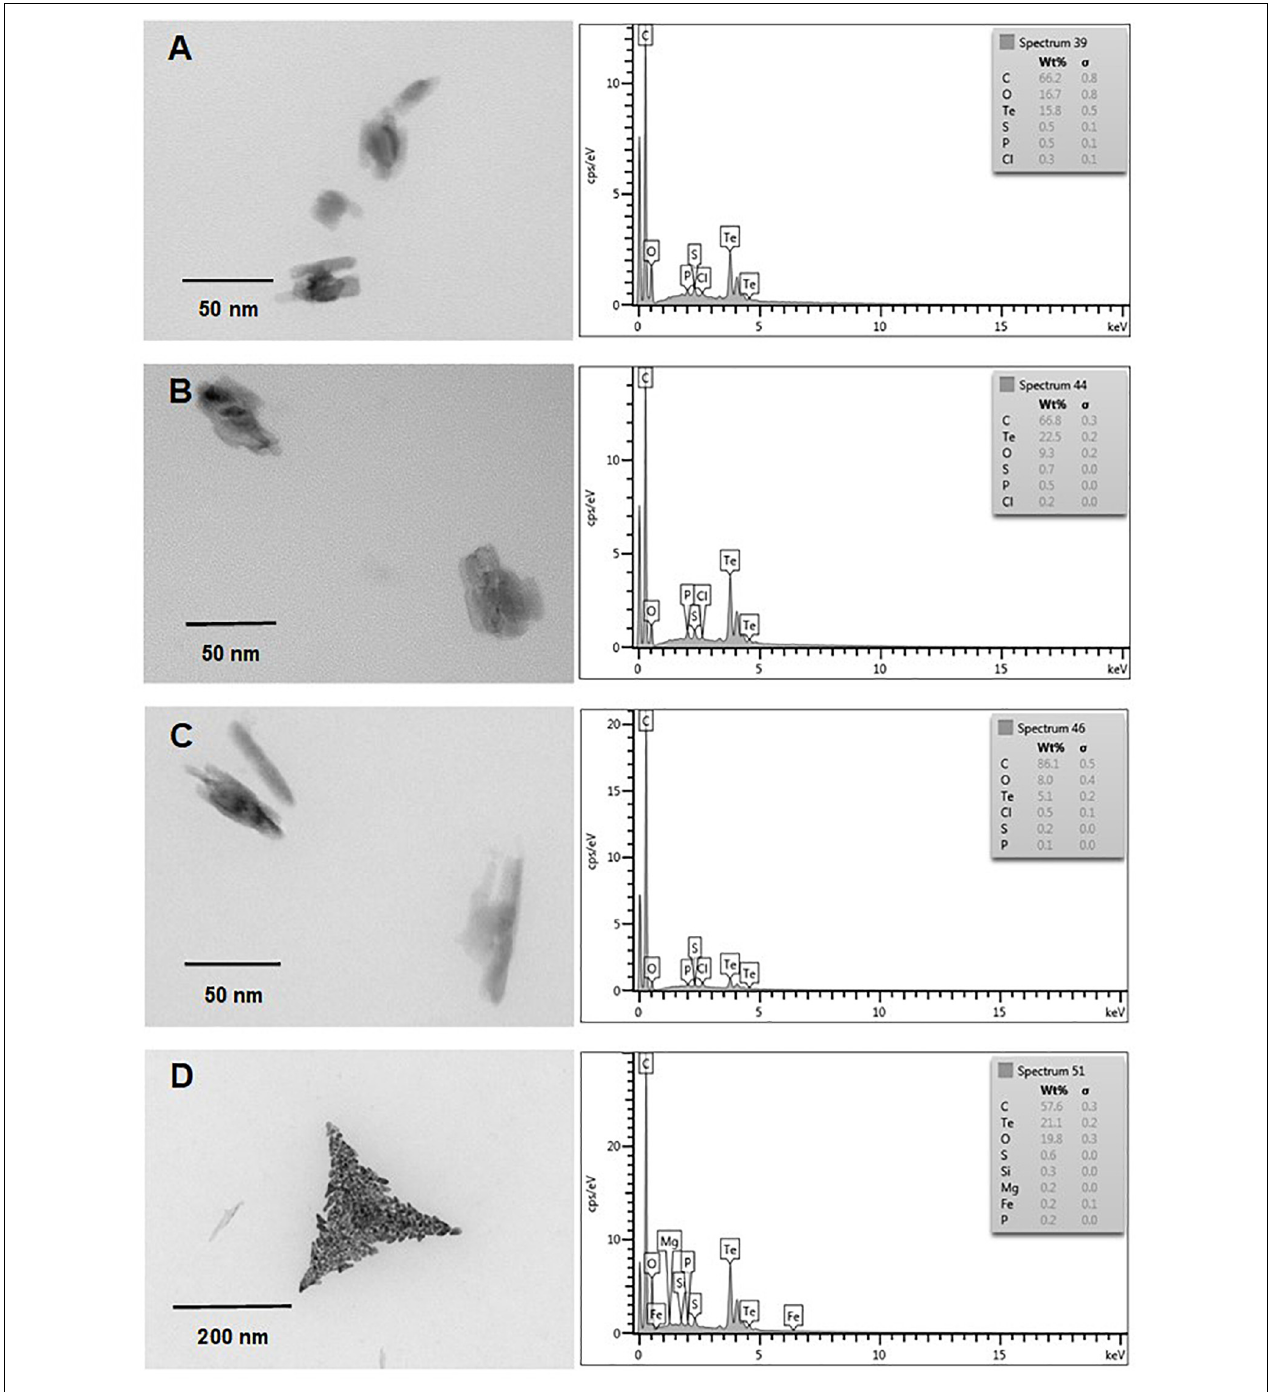
FIGURE 8 | In vitro , anaerobic synthesis of TeNS by E. cloacae MF01 crude extracts. Electron micrographs (left) and EDS analysis (right) show TeNS synthesized under the following experimental conditions: (A) NADH / pH 8.0; (B) NADPH / pH 8.0; (C) NADH / pH 9.0; (D) NADPH / pH 9.0.